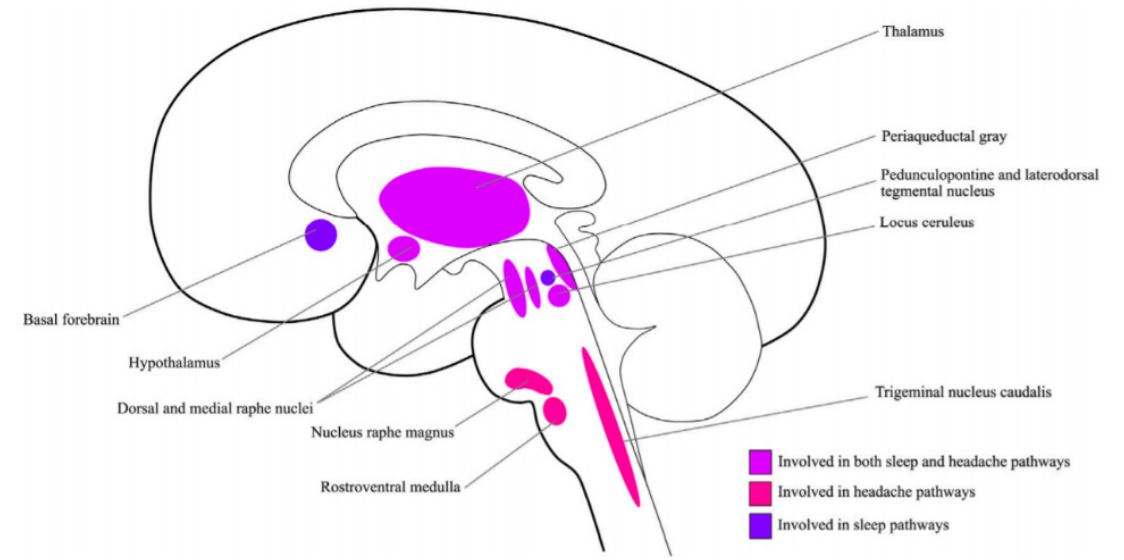
Figure 1. The key structures involved in sleep and headache pathways [19] (reused with permission, license number: 5132930606535, Elsevier and Copyright Clearance Center).